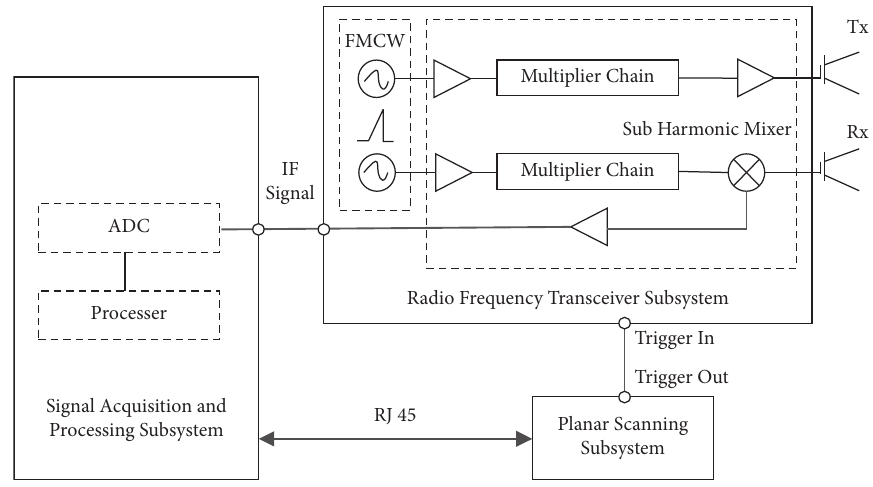
Figure 1: Schematic diagram of the developed THz FMCW imaging system. Table 1: The developed THz FMCW imaging system parameters.